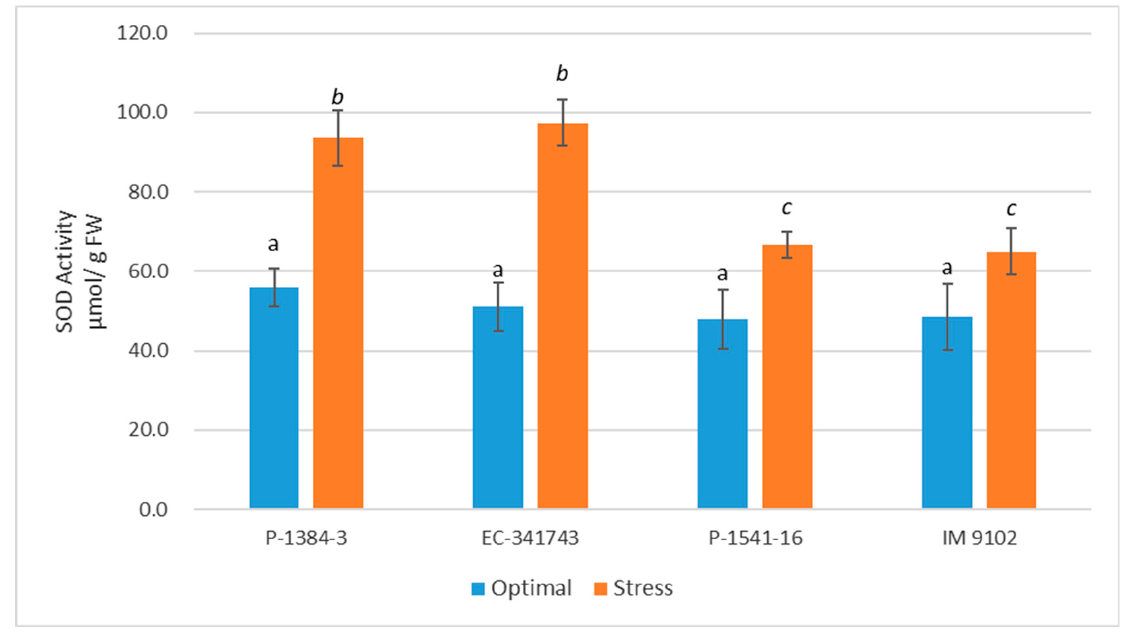
Figure 6. Activity of superoxide dismutase enzyme of four field pea genotypes optimal control and heat stress. Columns with different letters indicate significant difference at p ≤ 0.05 (Fisher LSD test).